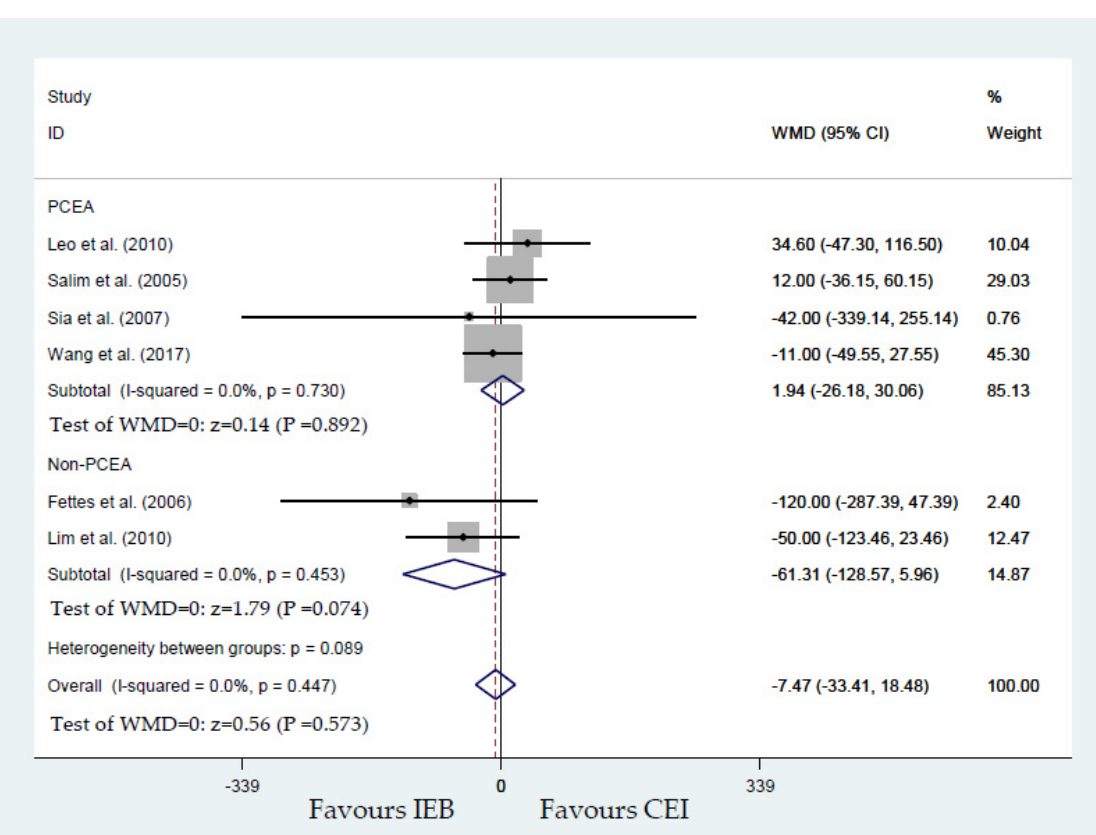
Figure 9. Overall e ff ect for the overall and subgroup analysis of duration (minutes) of the first stage of labor of labor analgesia.